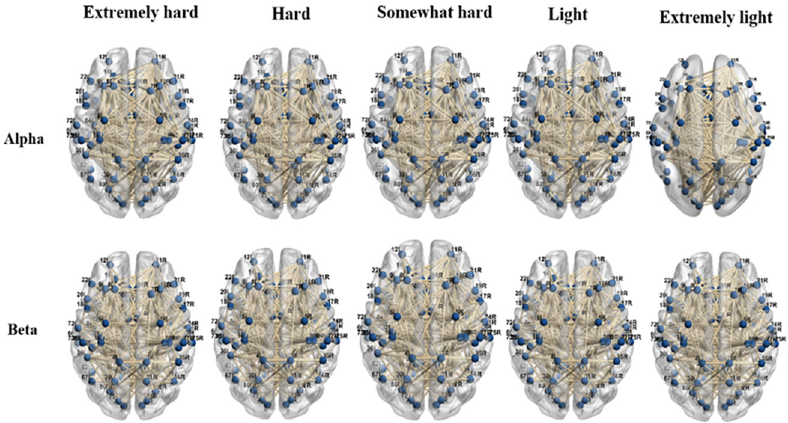
Figure 8. Visualization of the alpha and beta functional brain networks for all exertion levels based on the coherence method.